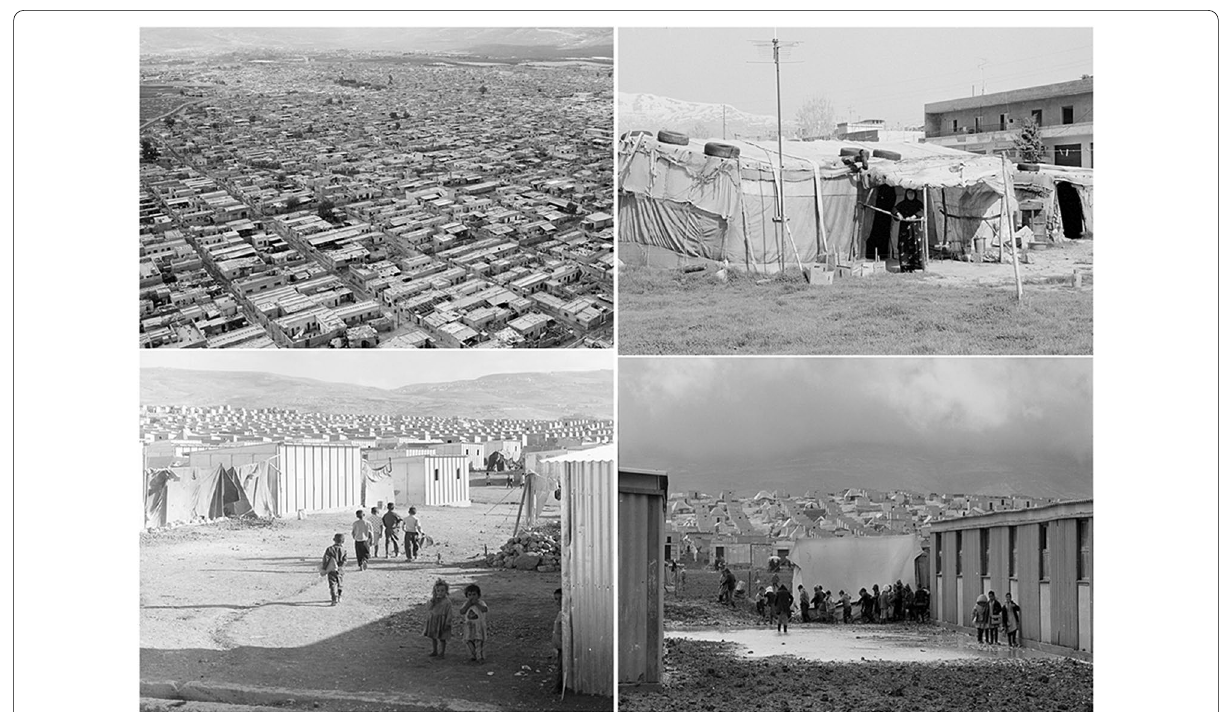
Fig. 9 (Top and bottom-left) Al Baqa’a emergency camp tents have been replaced with prefabricated shelters. © 1987 UNRWA archive photo by J. Shammout © 1969 UNRWA archive photo by George Nehmeh; (top-right) Winter snow in the hills behind Al Baqa’a camp in Jordan. © 1967 UNRWA archive; (bottom-right) Palestine refugee children endure the harsh living conditions associated with winter in Al Baqa’a emergency camp, East Jordan, 1970. © 1970 UNRWA archive photo by Munir